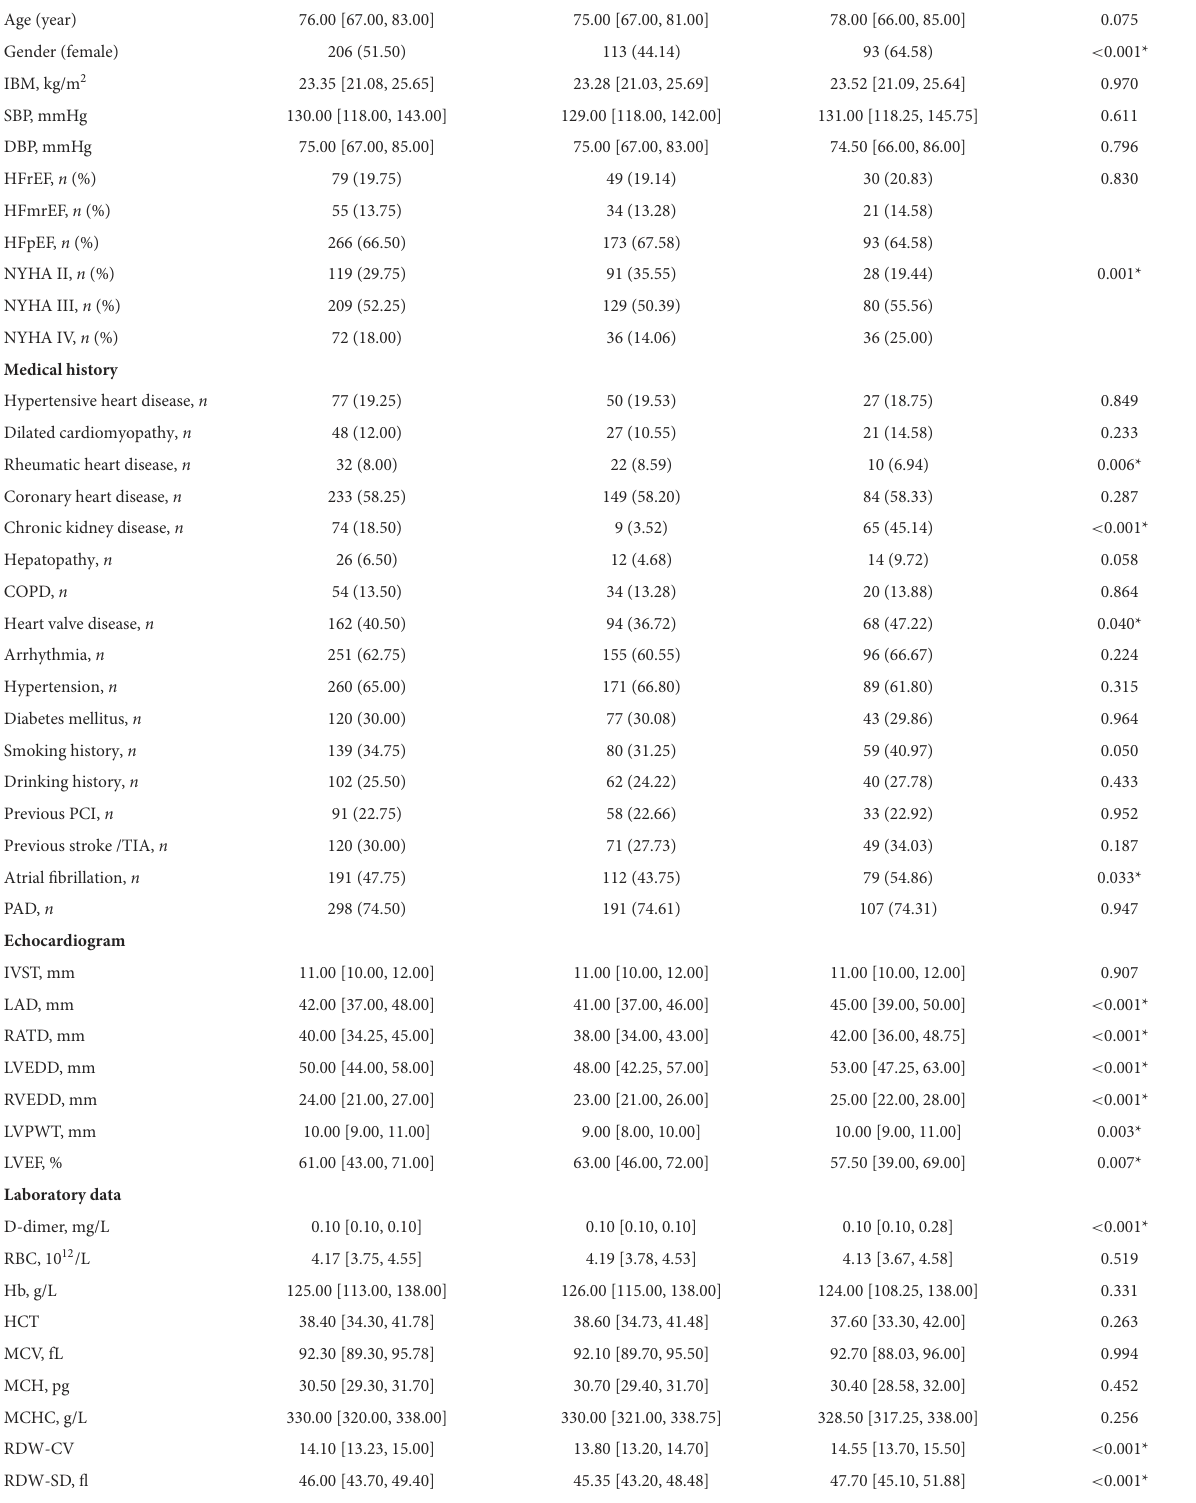
TABLE 1 Baseline characteristics of study